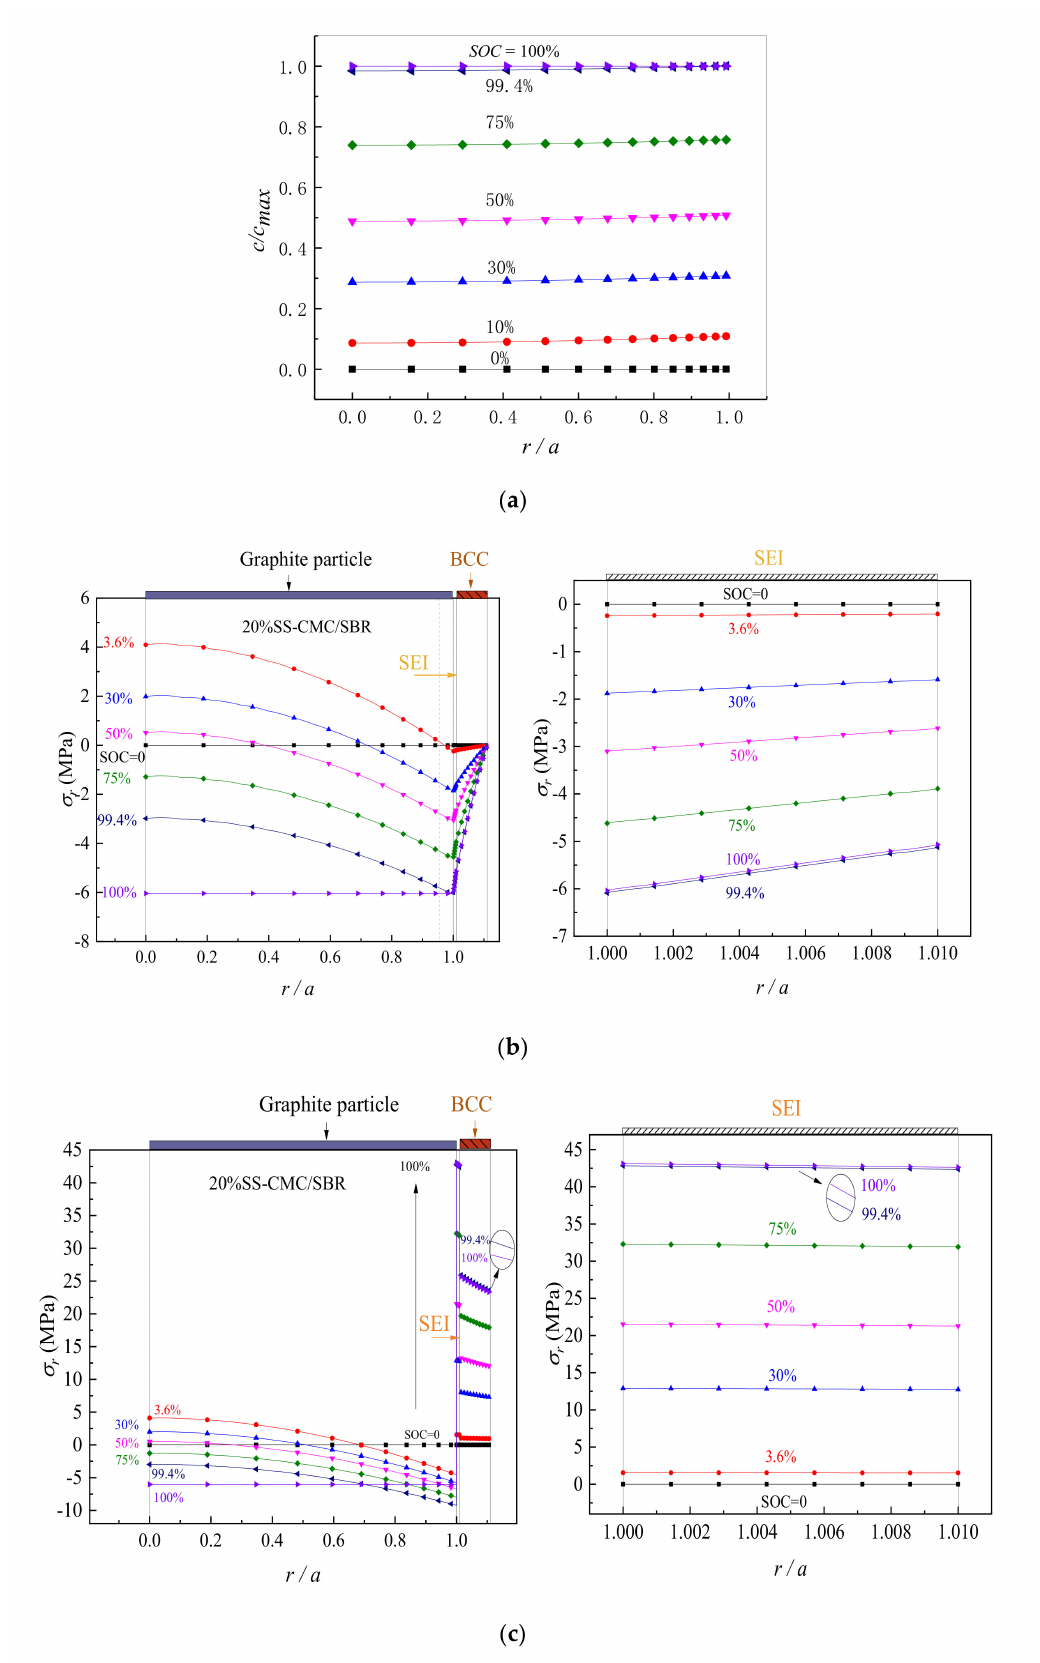
Figure 3. Distribution of Li concentration and stress in electrode system under di ff erent states of charge (SOC) (1C rate). ( a ) Lithium concentration in graphite particle; ( b ) radial stress; ( c ) hoop